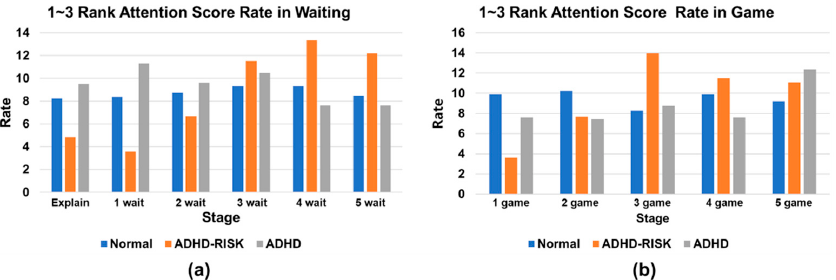
Figure 9. Graph of the distribution rate of the top three attention scores for the three classes for each stage. ( a ) Waiting. ( b ) Game.